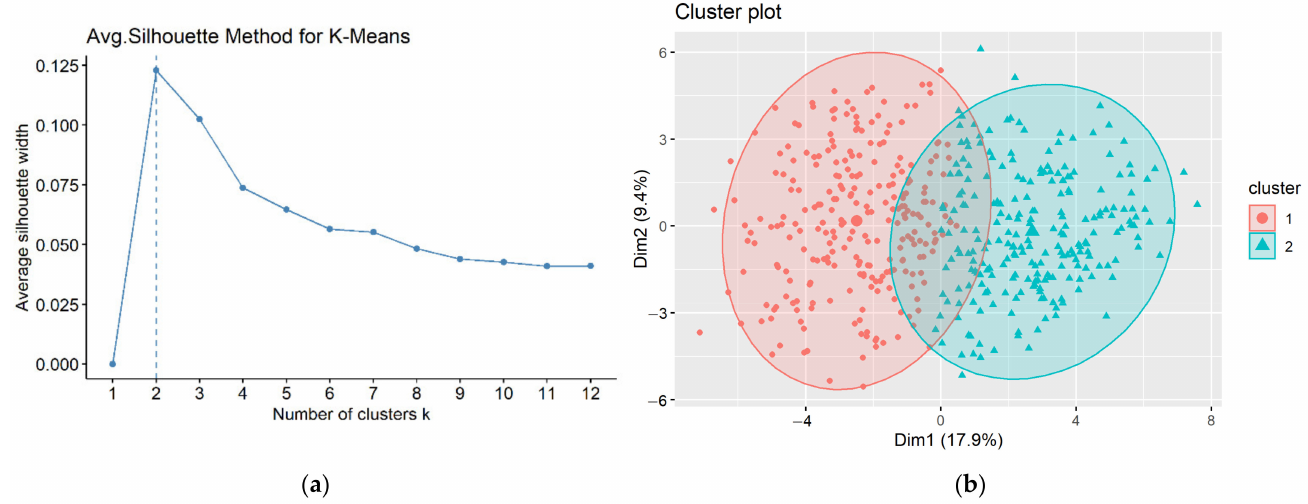
Figure 4. ( a ) The silhouette index plot indicating that the optimal number of clusters was two, ( b ) clustering plot of patients according to the K-means